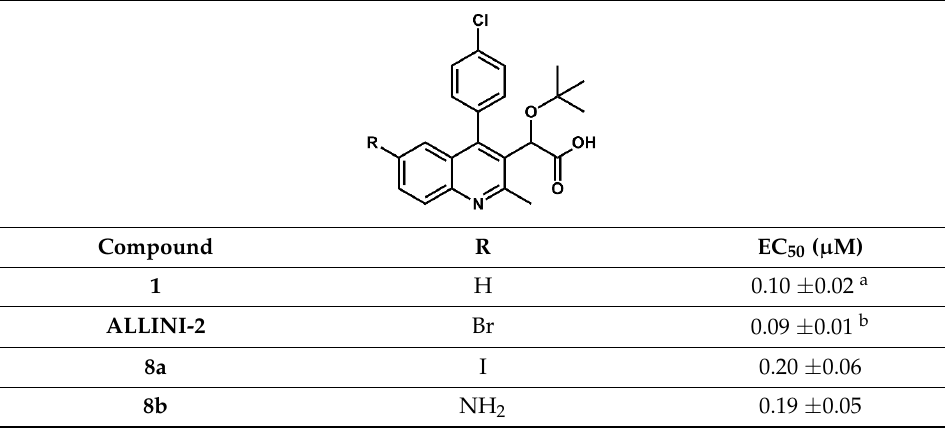
Table 2. In vitro IN multimerization EC50 activities of 6-substituted-4-chlorophenyl quinolines. NA